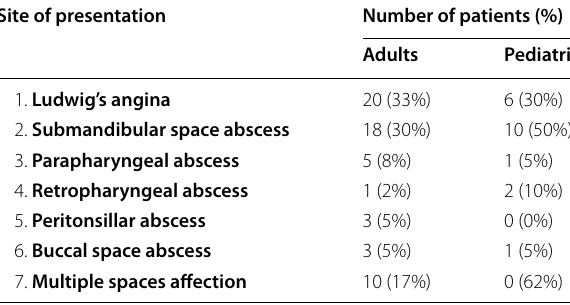
Table 2 Location of abscess in patients with DNSI Site of presentation